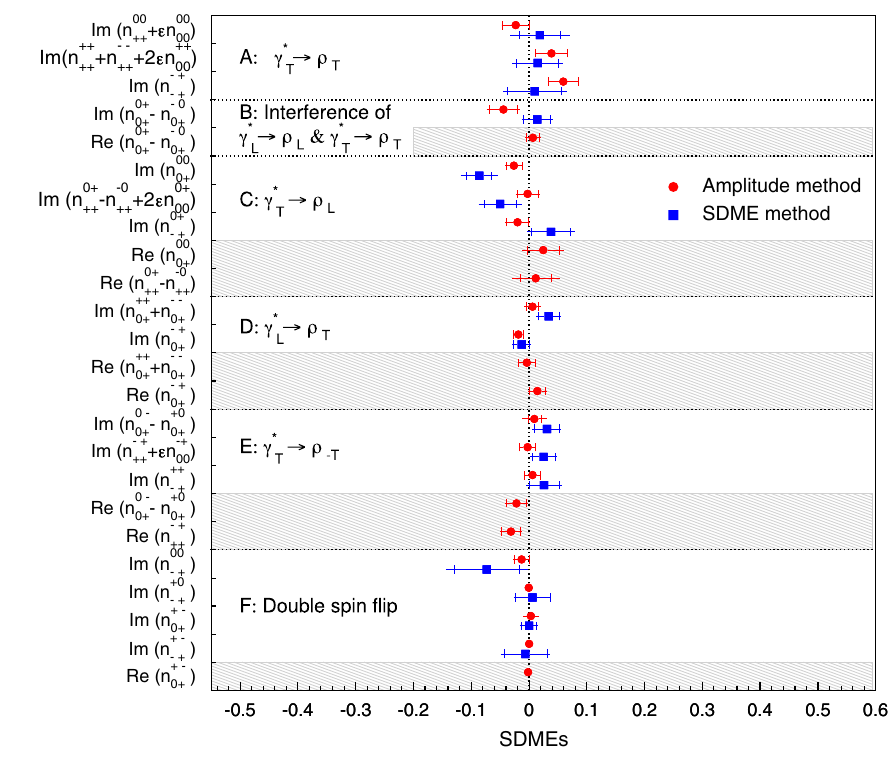
λ V λ (cid:2) V λ required for all SDMEs here. An additional scale uncertainty of 2% Fig. 4 Comparison of the SDMEs n obtained from the amplitude γ λ (cid:2) γ originating from the uncertainty on the beam polarization is present for method ( red circles ) and from the SDME method ( blue squares ). The these SDMEs, but not shown. The inner ( outer ) error bars represent SDMEs are extracted in the entire kinematic region. For the ampli- the statistical (total) uncertainty. An additional scale uncertainty of 8% tude method a 25-parameter fit is used, while the results of the SDME originating from the uncertainty on the target polarization is present, method are taken from the HERMES data in Ref. [29]. The points in but not shown. The SDMEs are ordered according to the SDME classes the shaded area show SDMEs that can be obtained only if the beam is proposed in Refs. longitudinally polarized in addition to the transverse target polarization